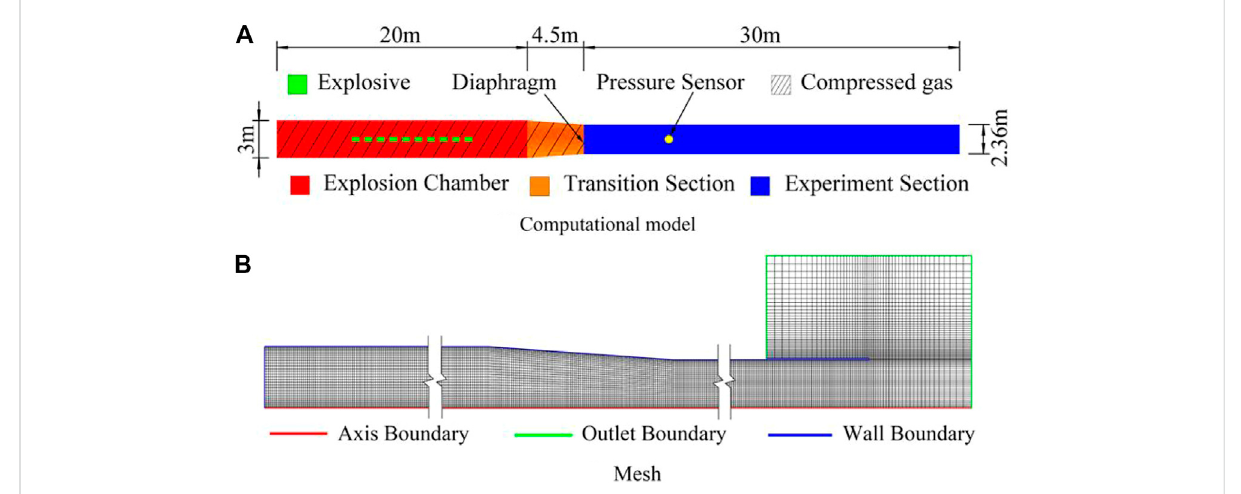
Schematic of a computational model and mesh. (A) Computational model. (B)